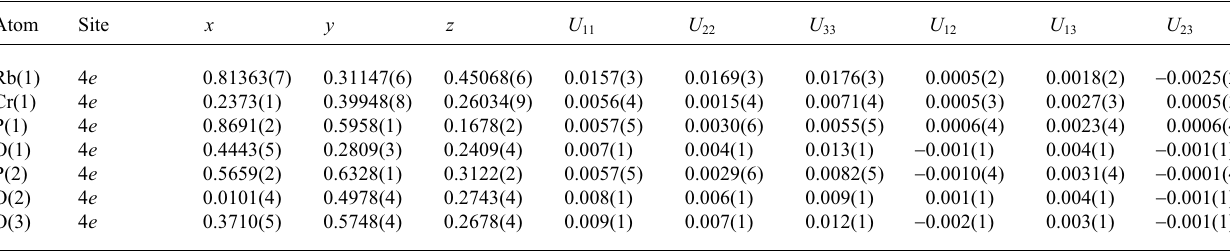
Table 2. Atomic coordinates and displacement parameters (in Å 2